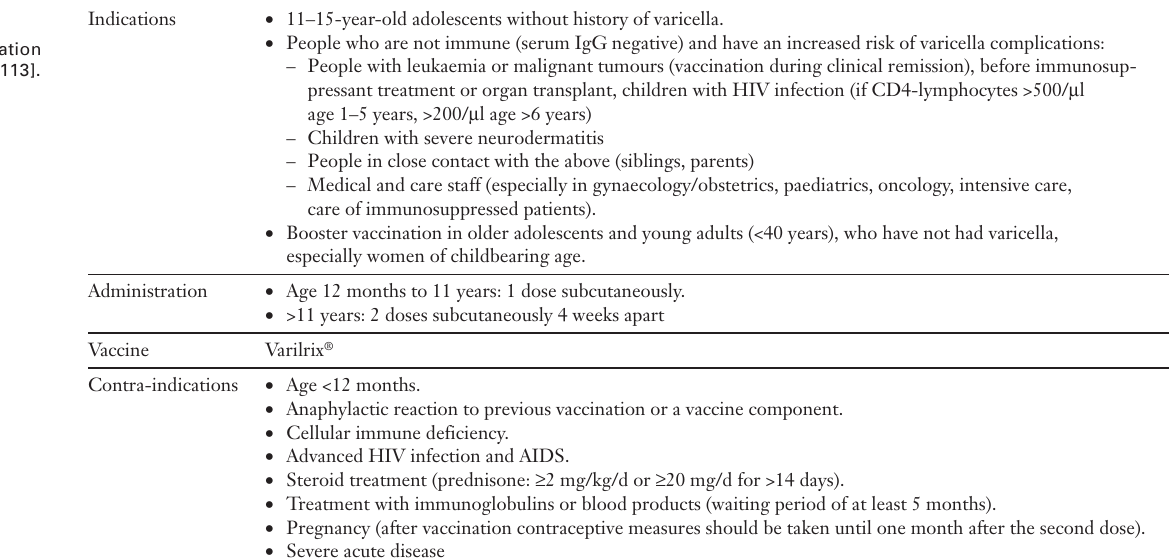
Varicella vaccination in Switzerland